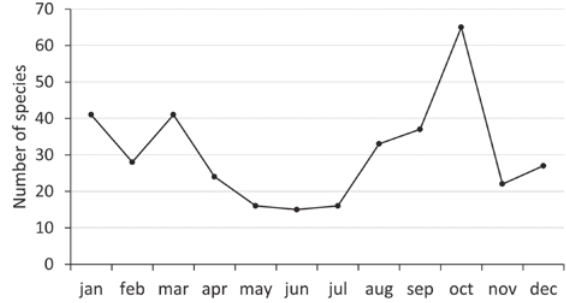
Figure 3 - Number of floristic species collected in the surrounding areas of three apiaries in the counties of Nova Aurora and Ubiratã (PR) from October 2008 to November 2009.